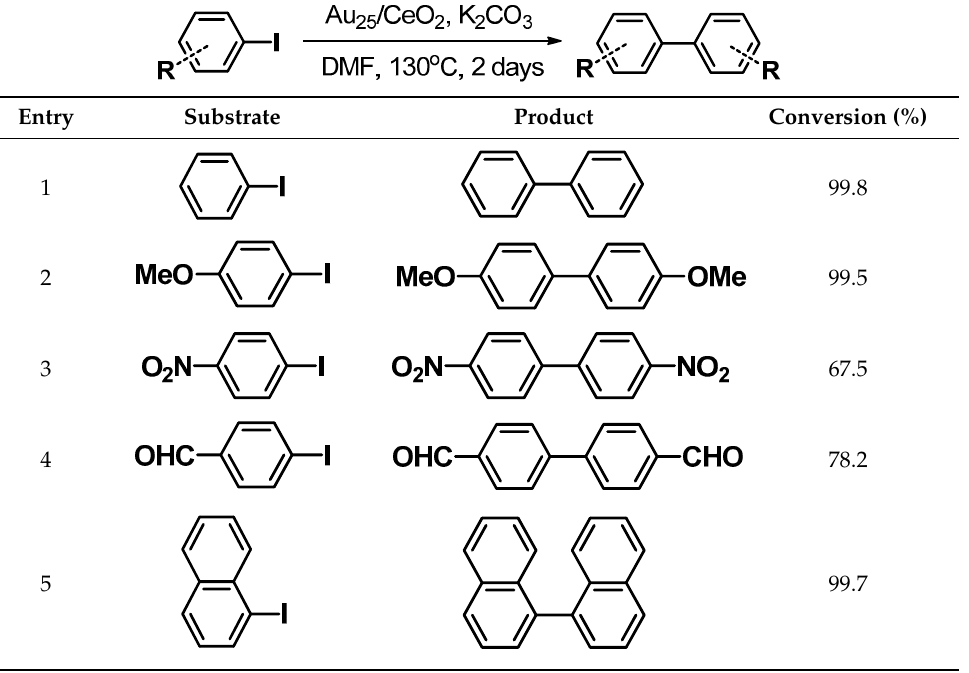
Table 1. The catalytic results over the Au 25 (PET) 18 /CeO 2 catalysts in Ullmann homo-coupling. Reaction